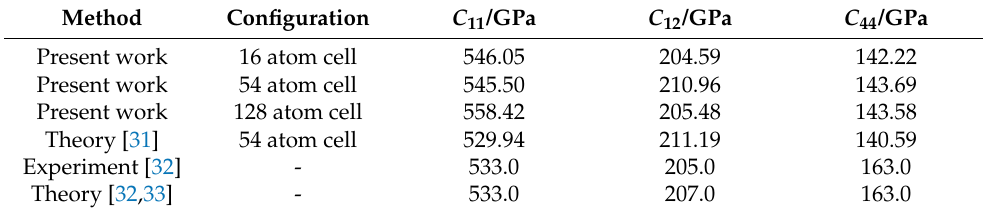
Table 1. Elastic constants of pure W.